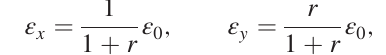
ˆ ε are sufficient to attain an x y ≫ 1 , x